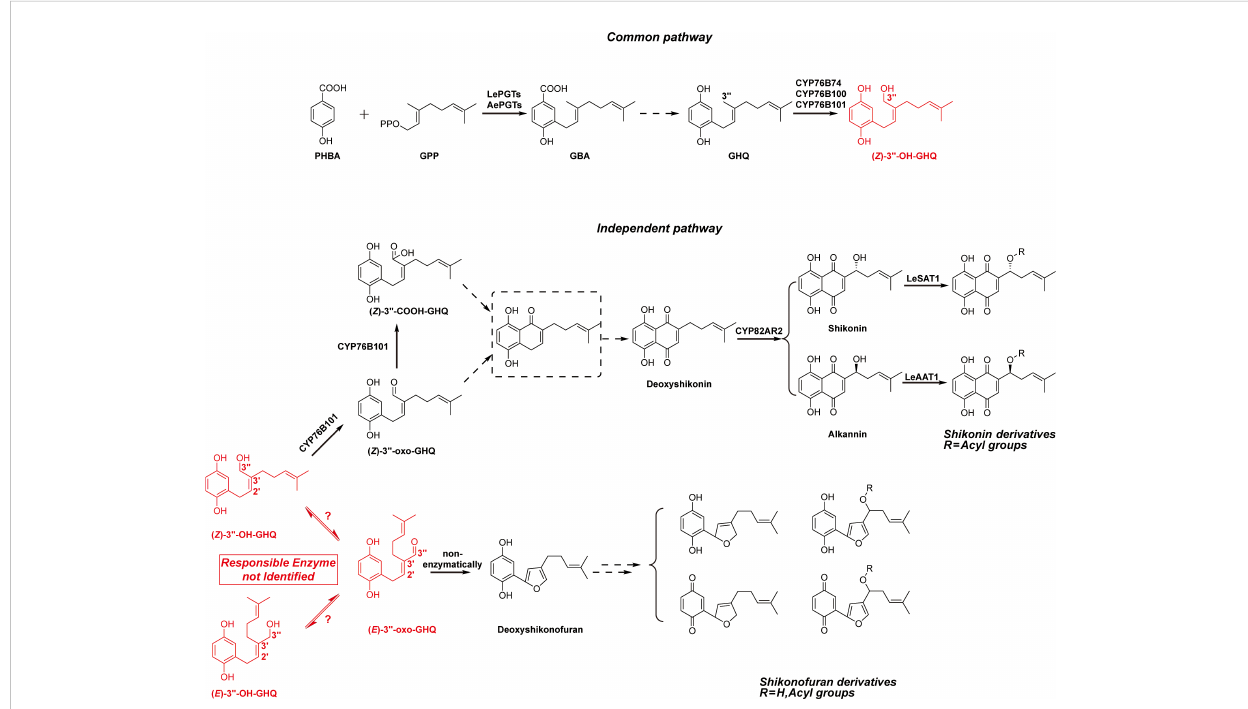
FIGURE 1 Simpli fi ed biosynthetic pathways of shikonin derivatives and shikonofuran derivatives. The branching reaction that directs the shikonin biosynthetic pathway to shikonofuran and the branch point intermediate ( Z )-3 ’’ -OH-GHQ are highlighted in red. The problem addressed in this study is highlighted in red box. Putative intermediates and yet unidenti fi ed reactions are denoted with dashed box and